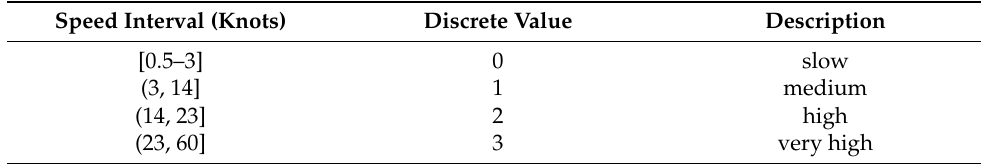
Table 2. Speed discretization into four slots.